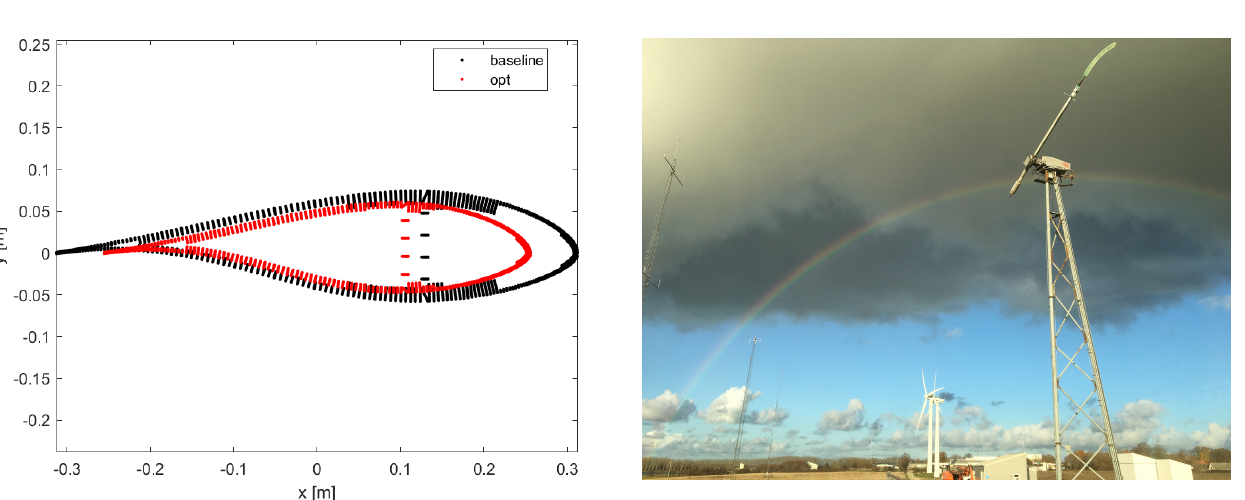
Figure 7. The tip mounted on the RTR and nearby met mast.